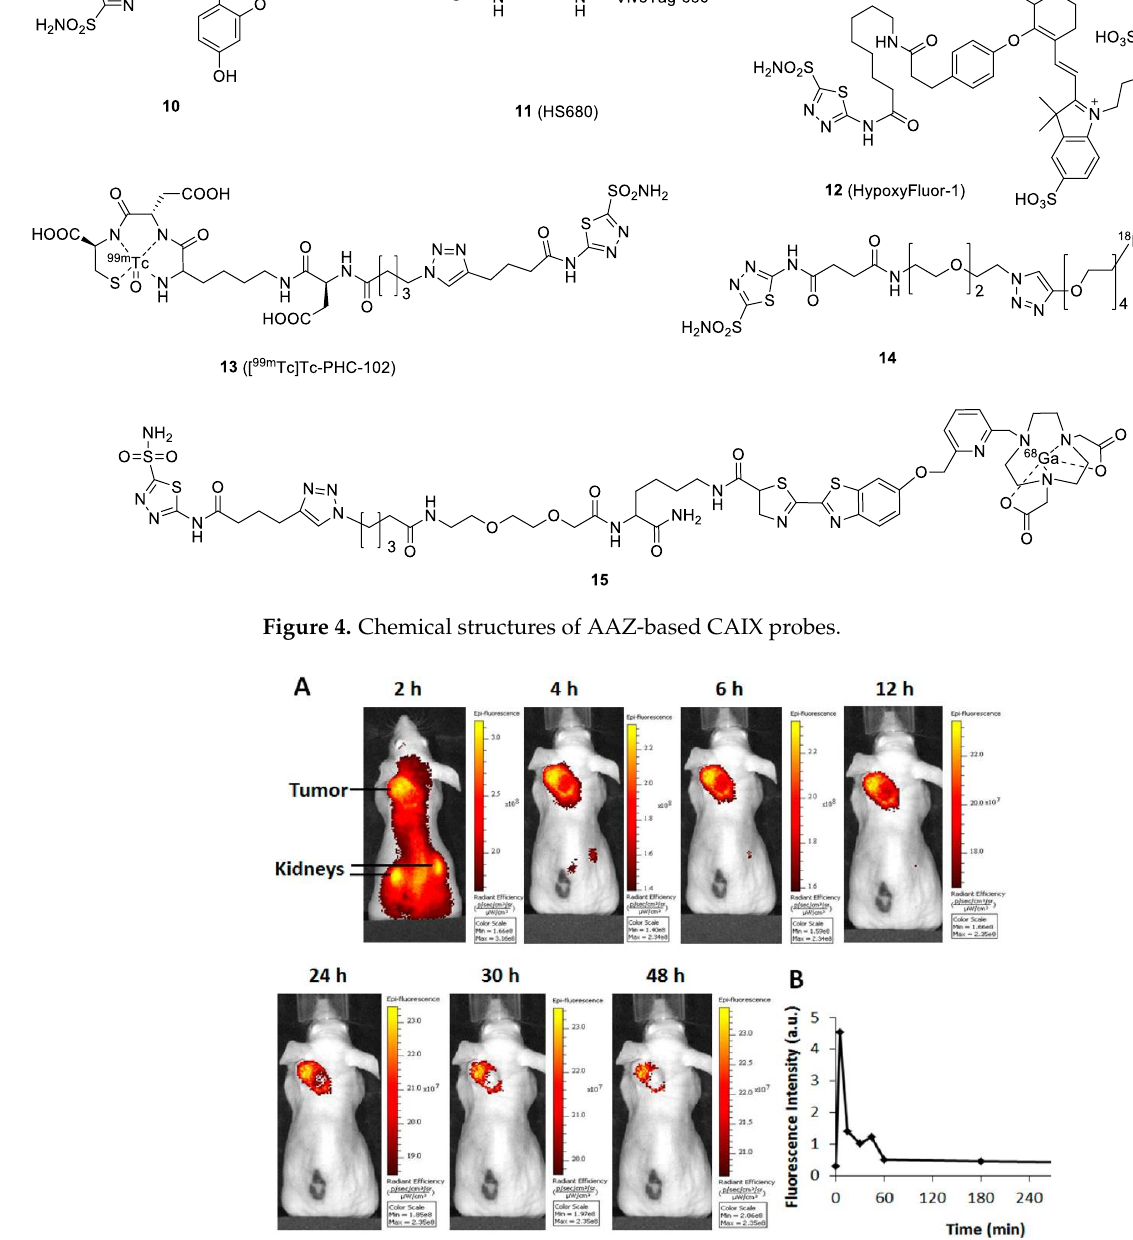
Figure 5. ( A ) Tumor accumulation and circulation half-life of HypoxyFluor-1 ( 12 ) in CAIX positive HT-29 tumor-bearing mice. ( B ) The tracer was eliminated from blood within 1 h. In addition to fluorescence imaging, AAZs have also been applied to generate radio- tracers for CAIX detection. Building on the initial success of the fluorescein-labeled probe, Krall and colleagues developed the [ 99m Tc]Tc-PHC-102 ( 13 ), also known as “ Onco IX ” , us- ing a tripeptide (Lys-Asp-Cys) chelator for 99m Tc labeling [46]. The probe showed a high tumor uptake and an excellent SPECT imaging contrast in the renal cell carcinoma SKRC- 52 model, but also a high kidney uptake (Figure 6). In the biodistribution study, maximal